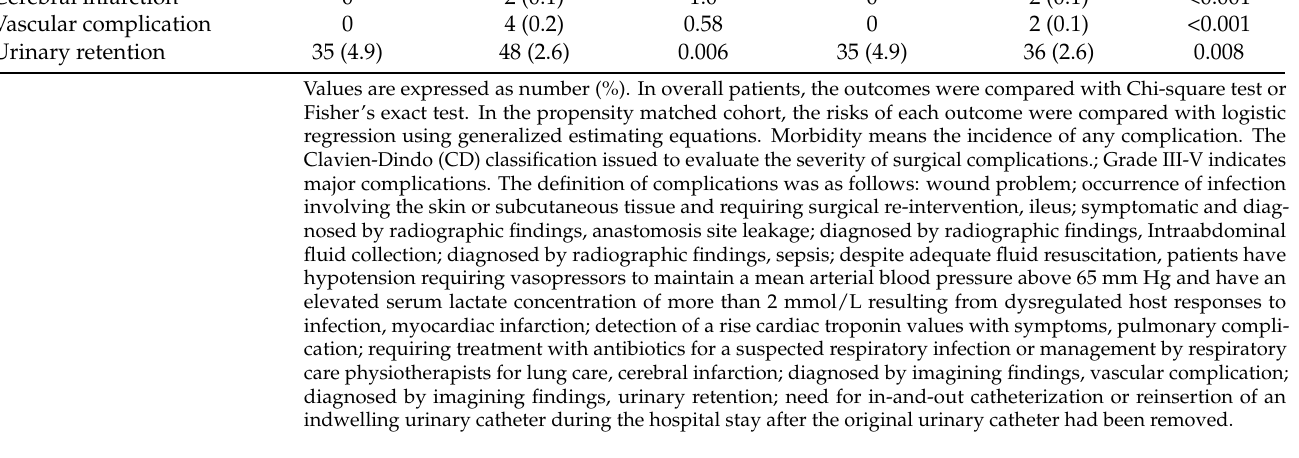
Table 3. Cox regression proportional hazard overall survival and recurrence-free survival: multivari- able model for overall patients. Recurrence-Free